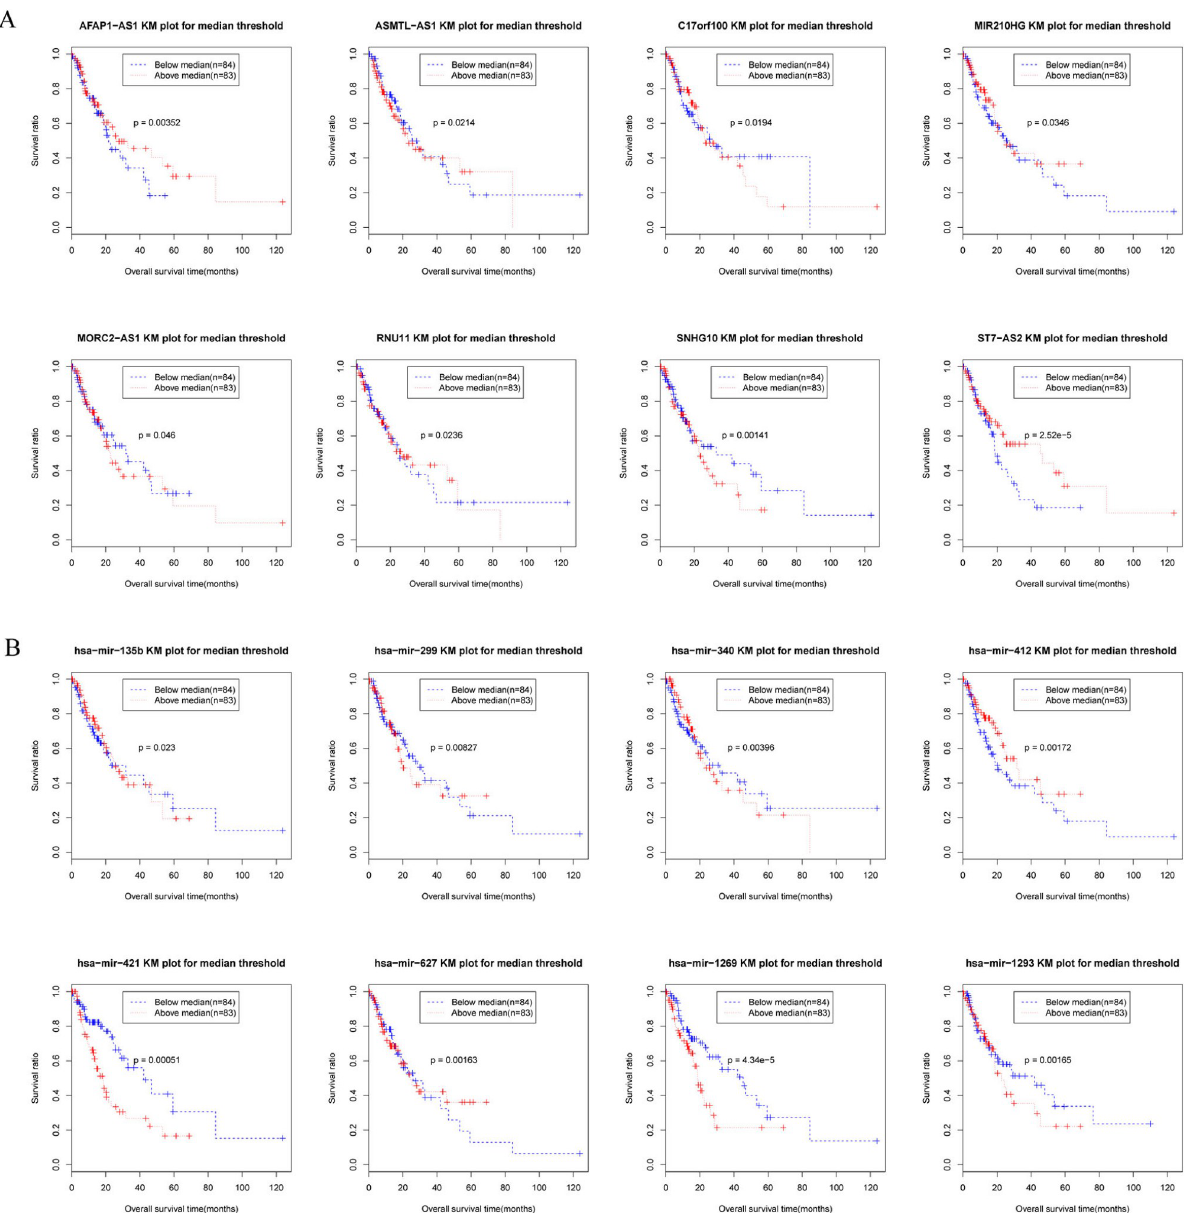
Fig 3. Prognosis related lncRNAs and miRNAs. Univariate Cox regression for differentially expressed lncRNAs and miRNAs identified eight lncRNAs and eight miRNAs were associated with overall survival of patients with alcohol-related esophageal cancer. Kaplan–Meier survival curves showed the survival differences between high and low expression (grouping by median expression value) of the eight prognostic lncRNAs (A) and eight prognostic miRNAs (B).